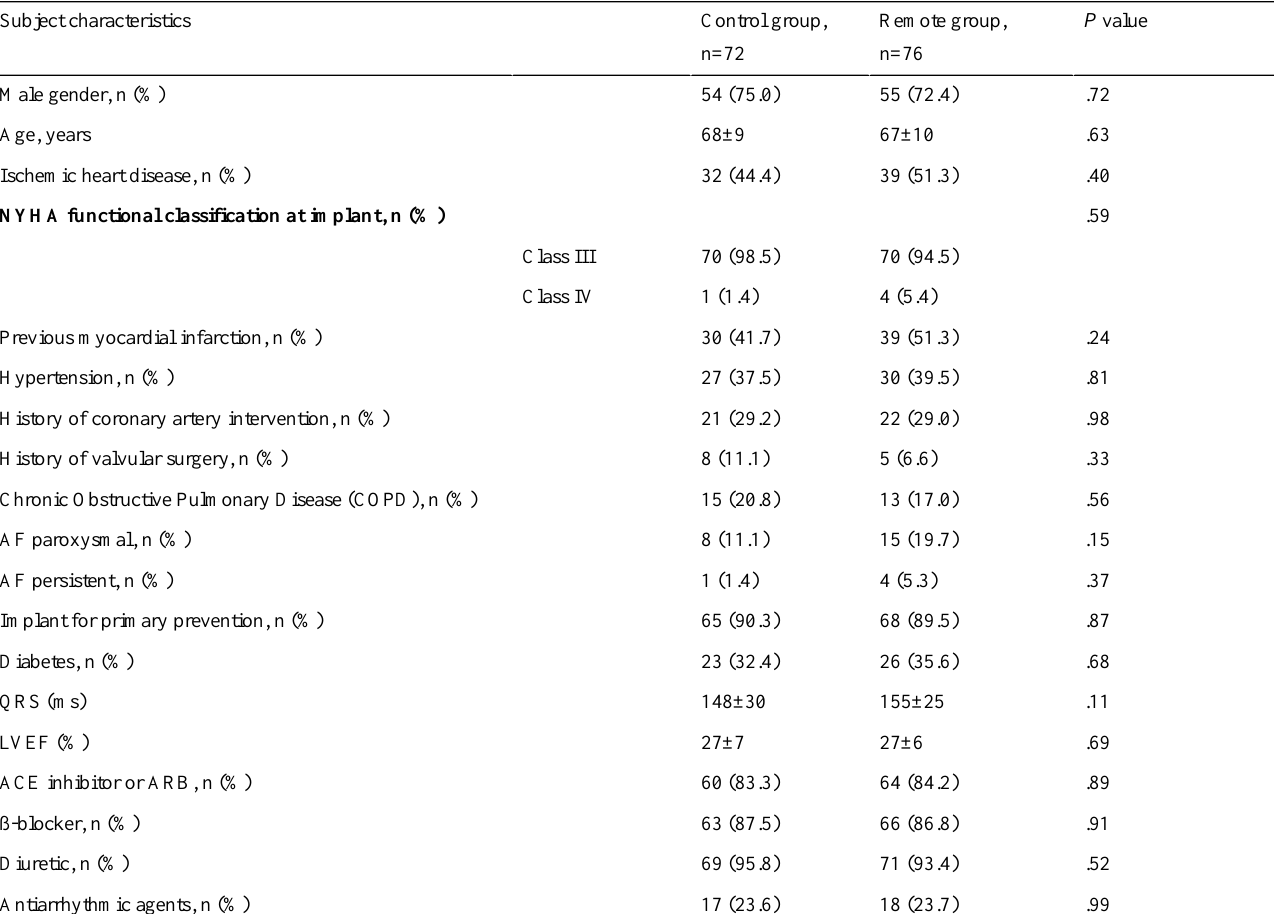
Table 1. Demographics and baseline clinical